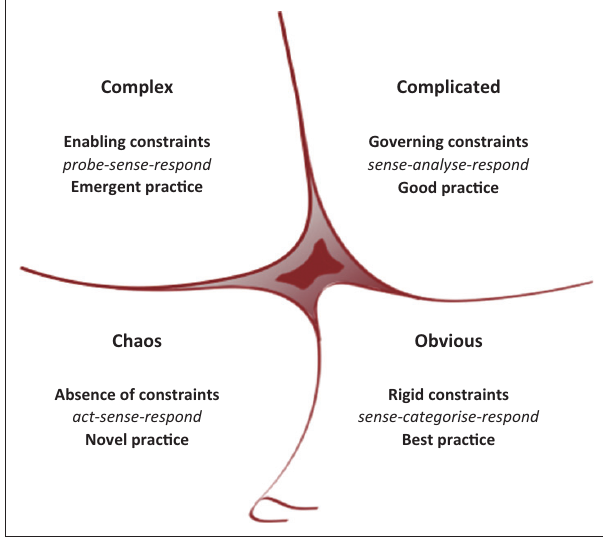
FIGURE 3: The Cynefin